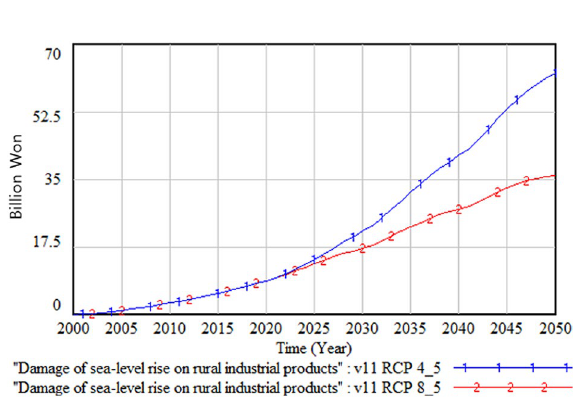
Figure 19. Urban industrial output decrease due to sea-level rise.